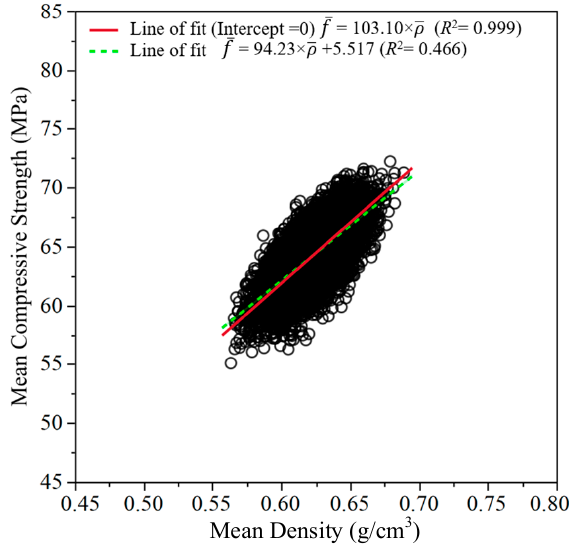
Figure 8. Relationship between average compressive strength and density of the lamina by Monte Carlo simulation.